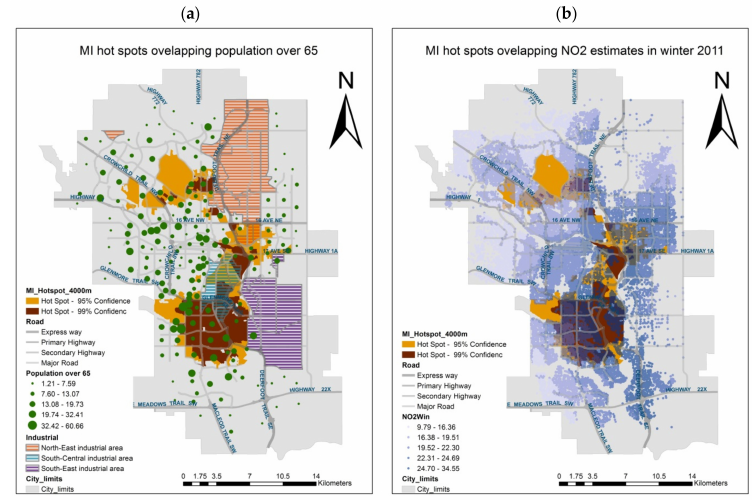
Figure 6. MI hot spots overlaying ( a ) population over 65, and ( b ) air pollution.